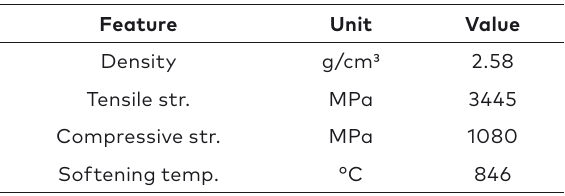
Table 5. Physical properties of glass